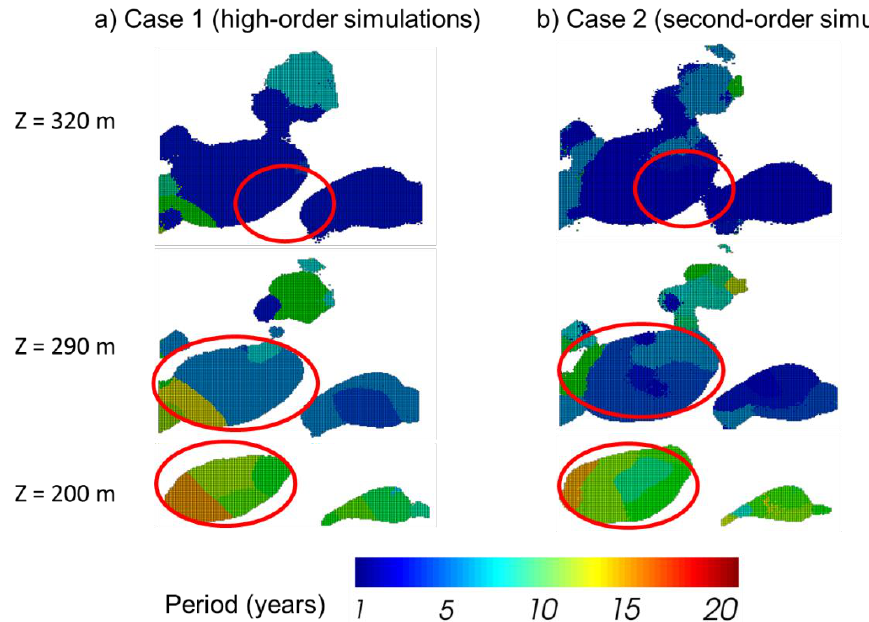
Figure 7. Cross-section of the LOM production schedule (plane North–South) obtained in ( a ) Case 1 and ( b ) Case 2. The red arrows show the preferential mining direction in the direction of higher continuity of high-grades.